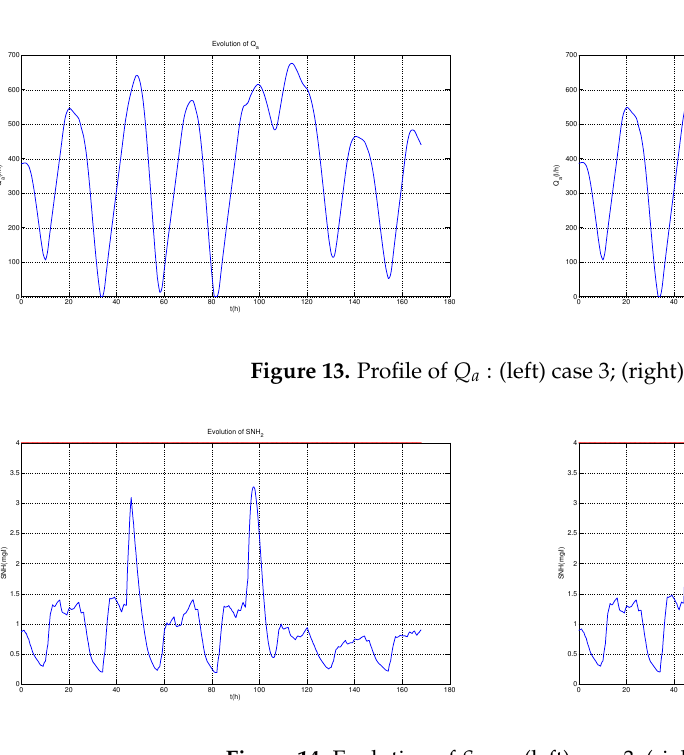
Figure 14. Evolution of S NH : (left) case 3; (right) case 4.